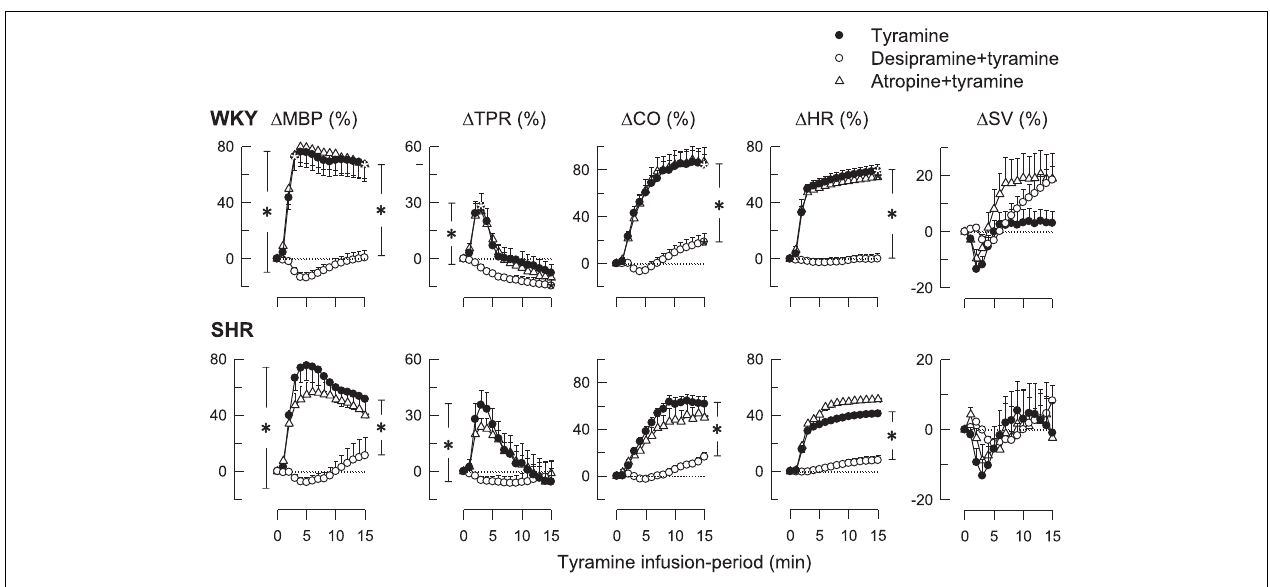
and ∆ SV, and at 15min for ∆ CO and ∆ HR, as indicated. Significant group differences at 3min (* in left brackets) or 15min (* in right brackets) were detected as indicated. Baselines prior to tyramine are shown in Table 1 . *within symbols: P ≤ 0.025 for ∆ MBP, ∆ TPR and ∆ SV, and P ≤ 0.05 for ∆ CO and ∆ HR. * in brackets: P ≤ 0.001.